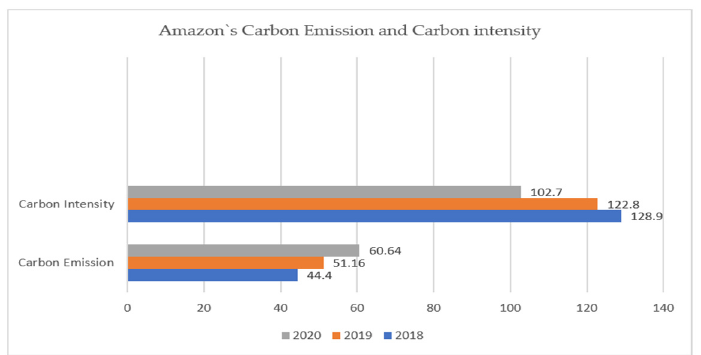
Figure 1. Carbon emissions and carbon intensity. Source: Amazon Sustainability Report 2020.